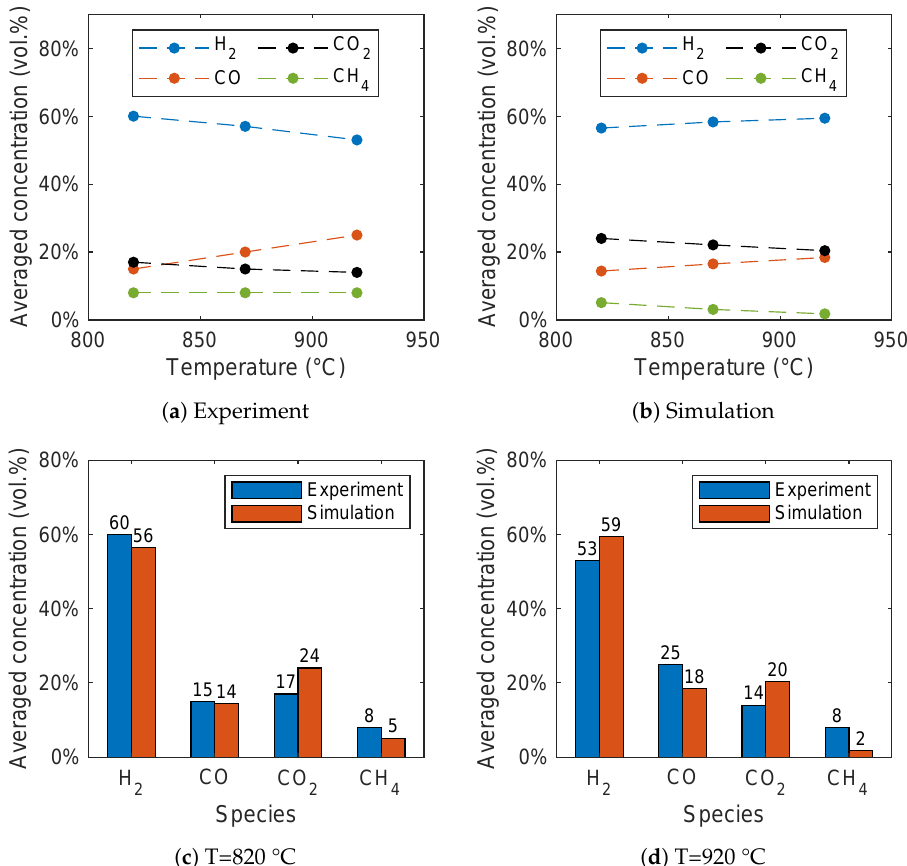
Figure 7. Influence of the reactor temperature on the syngas composition for ( a ) the experimental data given by Song et al. [6] and ( b ) the simulation results. Comparison of the syngas composition for ( c ) 820 °C and ( d ) 920